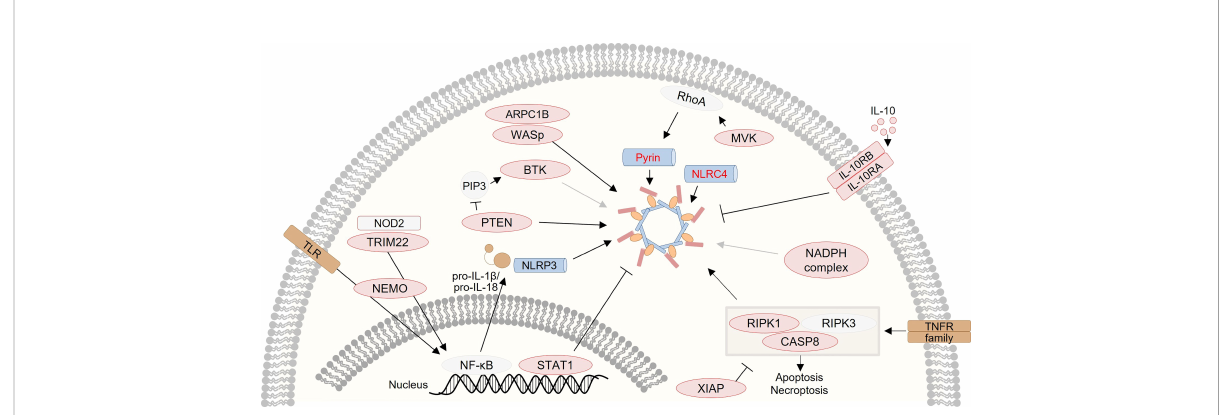
FIGURE 2 Graphical presentation of a network of in fl ammasome-associated monogenic defects causing VEO-IBD. Several proteins, that are several candidates for monogenic VEO-IBD (highlighted in red), have been shown to contribute to in fl ammasome dysregulation via various